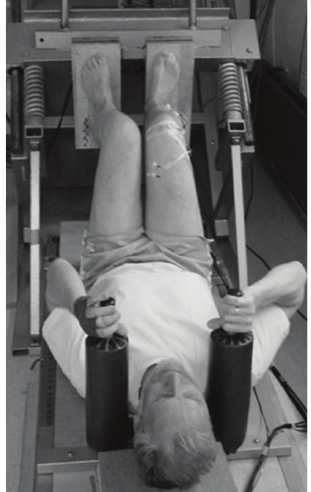
Figure 4: Assessment of maximal isometric strength and rate of force development using a leg press (i.e., force signals will be recorded by a separate force plates underneath the